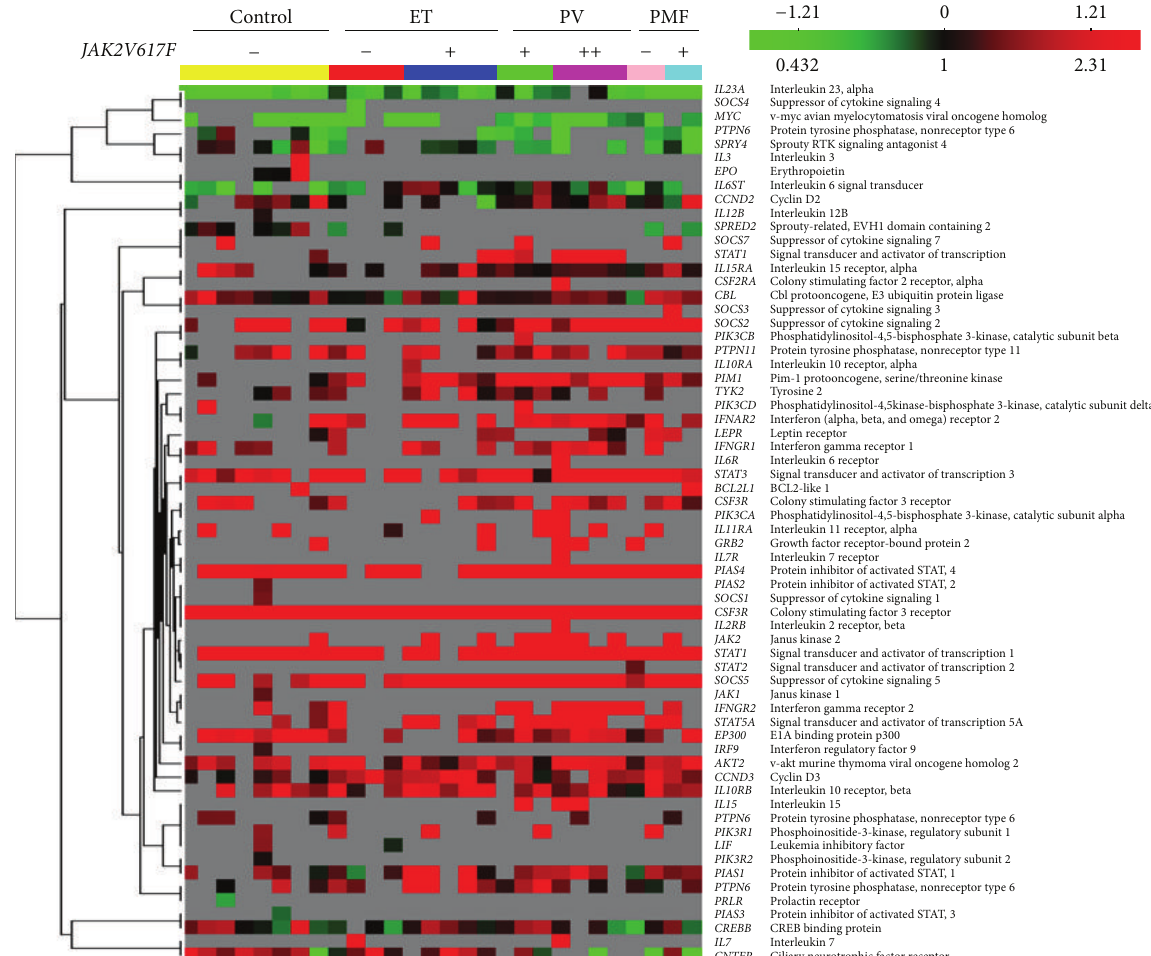
Figure 2: Hierarchical clustering of JAK-STAT signaling pathway related genes expressed in CD34 + cells of MPNs. The color indicates the relative fold expression of each gene: red indicates increased expression, green negative expression, and black not changed expression, while gray stands for absent expression per each examined sample. The gene correlations are